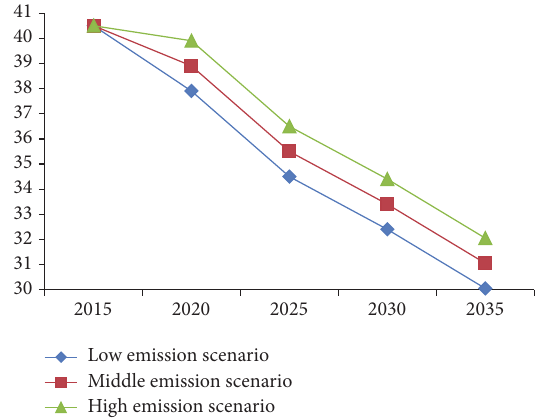
Figure 13: The trends of economic structure in the low, middle, and high emission scenarios (%).